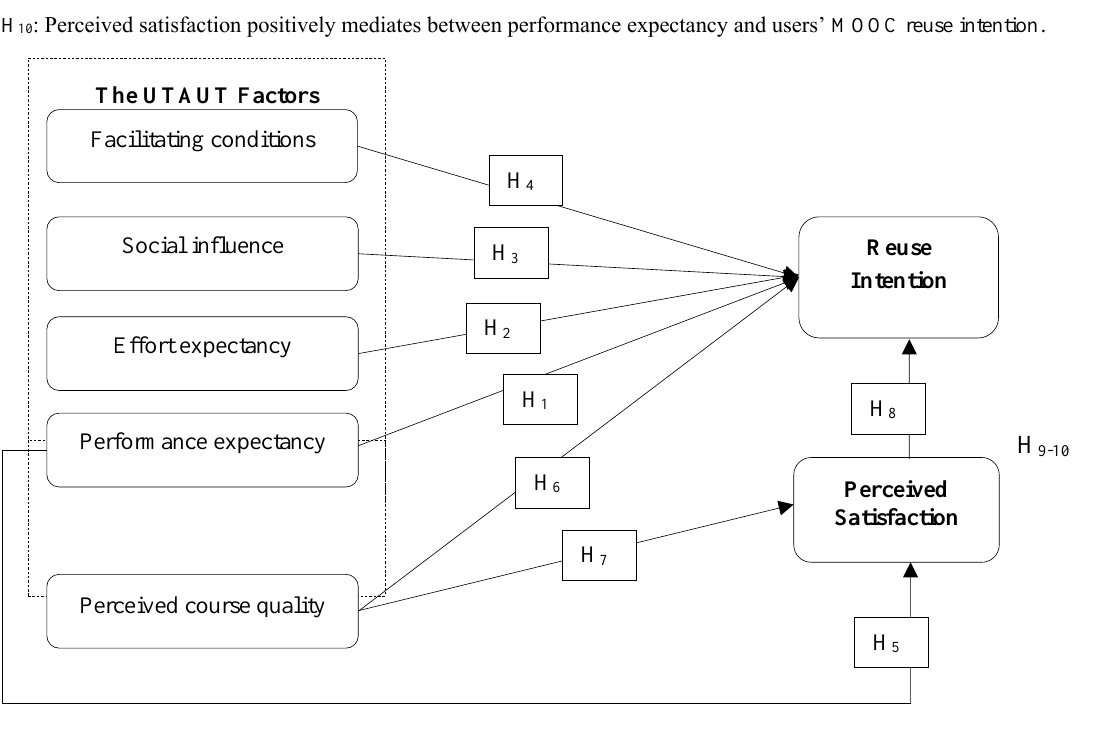
Figure 1: Theoretical Research